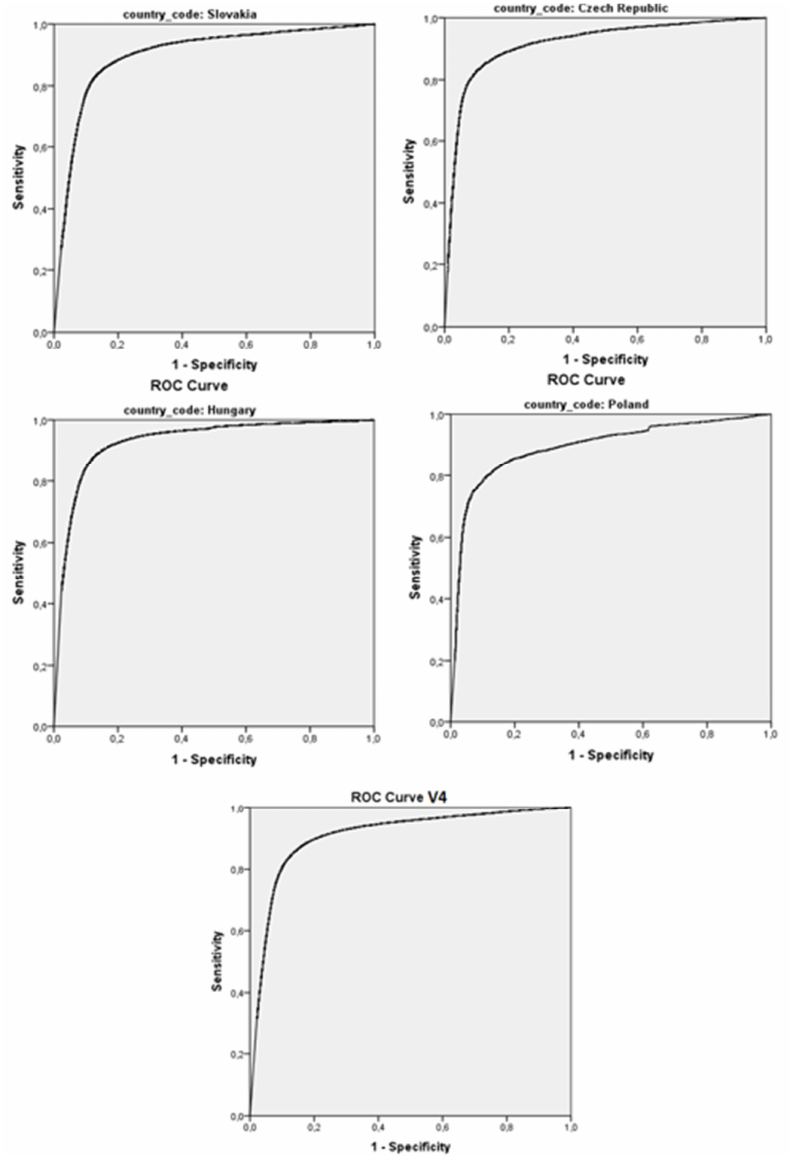
Figure 1. ROC curves of the prediction